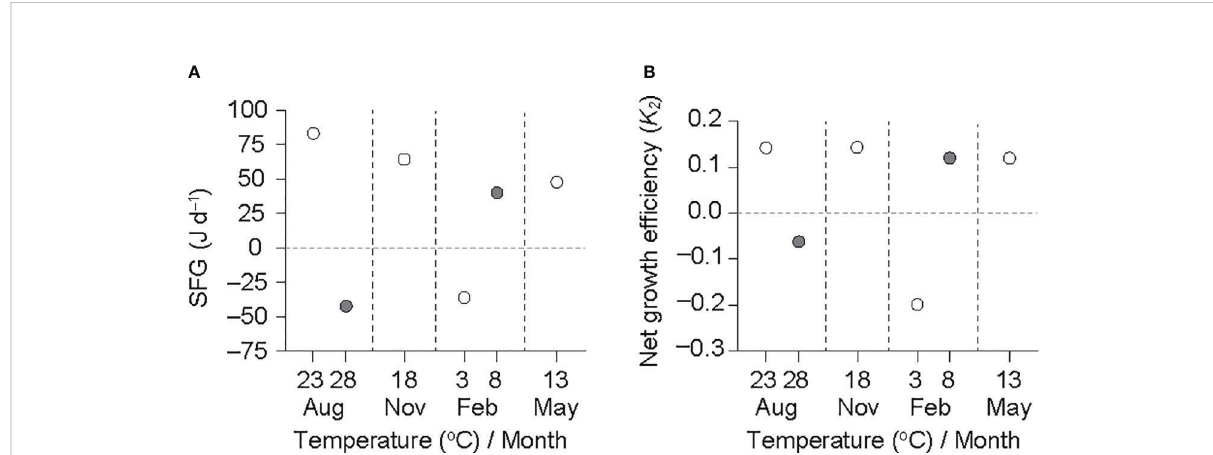
FIGURE 5 Scope for growth (SFG) (A) and net growth ef fi ciency ( K 2 ) (B) in an individual ark shell ( Anadara kagoshimensis ) with a dry- fl esh weight of 0.6 g recorded in all six experimental groups in August and November 2017, and February and May 2018. The open and closed circles of August and February represent cold and warm conditions in summer and winter,